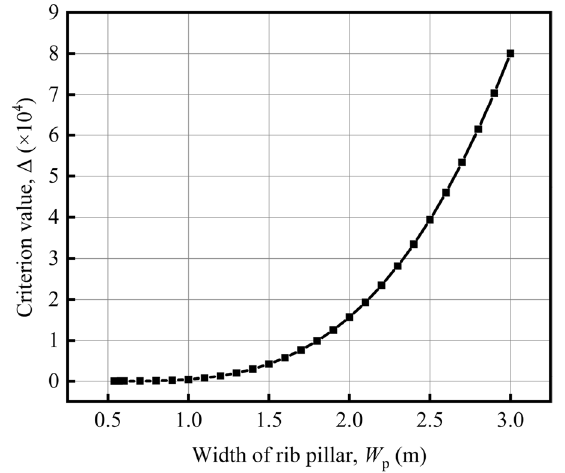
Fig. 17 Safety factor of the rib pillar under the No. 1 haulage